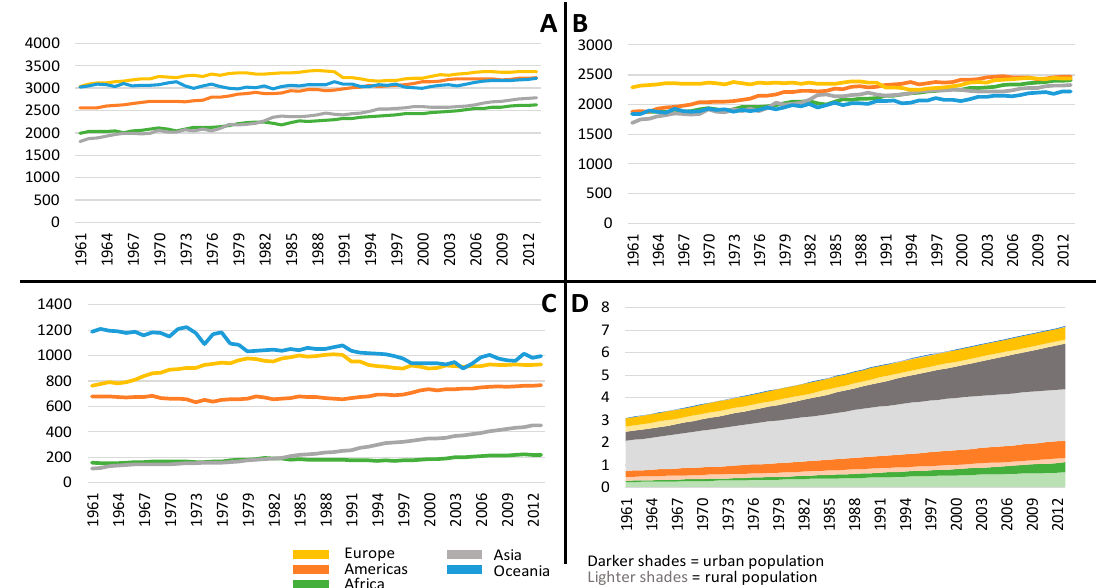
Figure 4. ( A ) Total Food supply since 1961 (y-axis: kcal/capita/day); ( B ) Food supply from vegetable products since 1961 (y-axis: kcal/capita/day); ( C ) Food supply from animal products since 1961 (y-axis: kcal/capita/day); ( D ) Urban and rural population developments since 1961 (y-axis: population in billions). Data derived from TED, FAO and IFA. All panels grouped by world regions as indicated in colour legend.